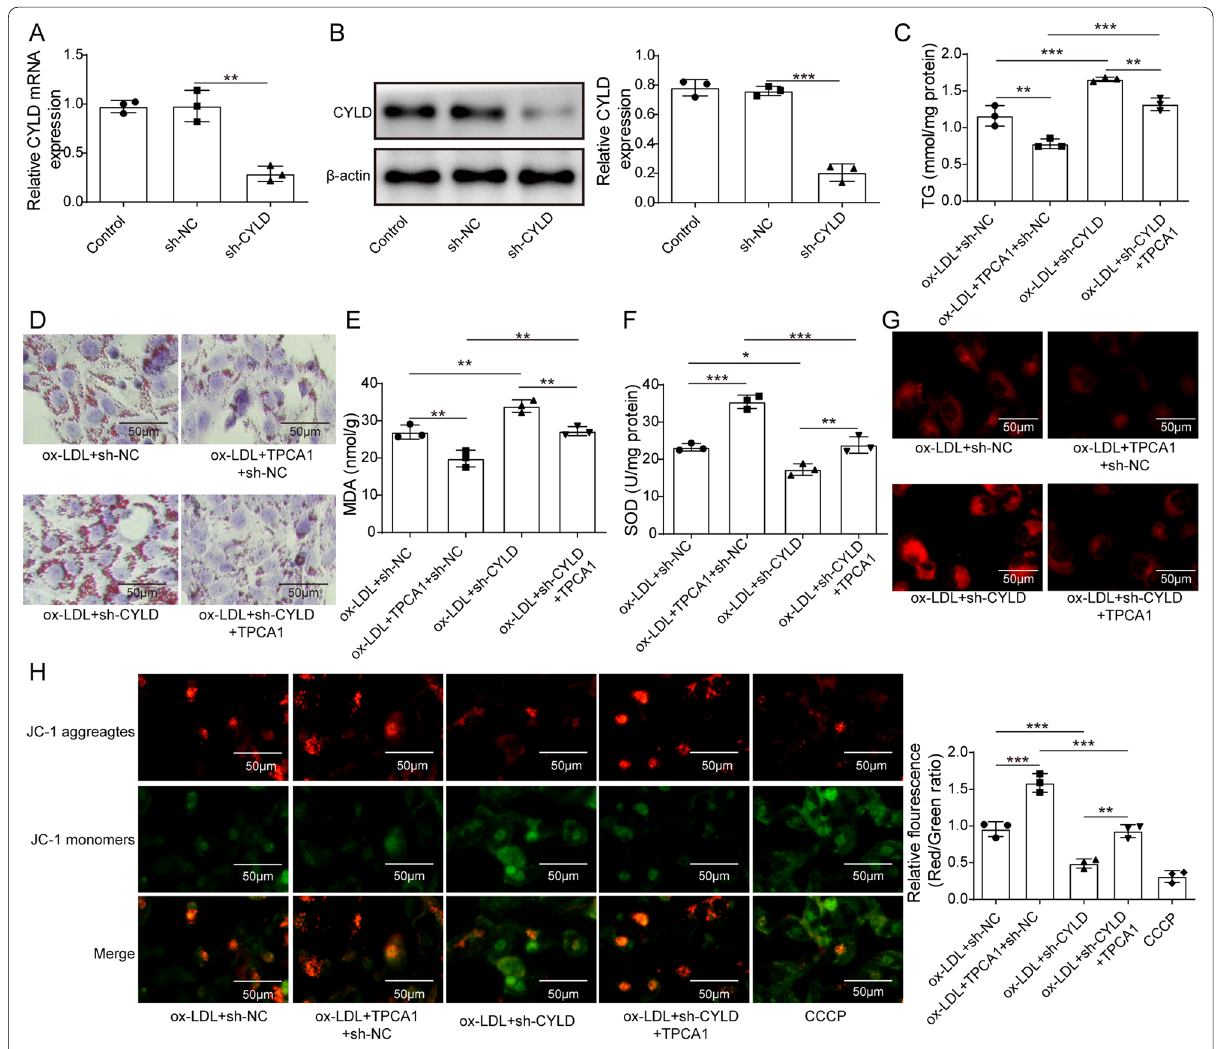
Fig. 5 Knockdown of CYLD attenuated the effect of an IKK inhibitor on oxidative stress injury in an in vitro ORN model. Cells were transfected with sh‑CYLD to silence CYLD expression and divided into four groups: ox‑LDL ox‑LDL TPCA1 sh‑CYLD. A and B The knockdown efficiency of sh‑CYLD was assessed using qRT–PCR and western blotting. C Effect of CYLD + + knockdown on TG levels in treated HK‑2 cells. D Lipid deposition in different groups was measured using Oil Red O staining. E and F MAD level and SOD activity of treated HK‑2 cells. G and H ROS levels and ΔΨm of treated HK‑2 cells were measured by DHE staining and JC‑1 assay, respectively. CYLD, cylindromatosis; IKK, IκB kinase; ORN, obesity‑related nephropathy; ox‑LDL, oxidized low‑density lipoprotein; NC, normal control; TG, triglyceride; HK‑2, human kidney 2; MAD, malondialdehyde; SOD, superoxide dismutase; DHE, dihydroethidium; ROS, reactive oxygen species; ΔΨm, mitochondrial membrane potential. Significance was assessed by an ANOVA test. The experimental data are shown as the mean *P < 0.05, **P < 0.01, ***P <